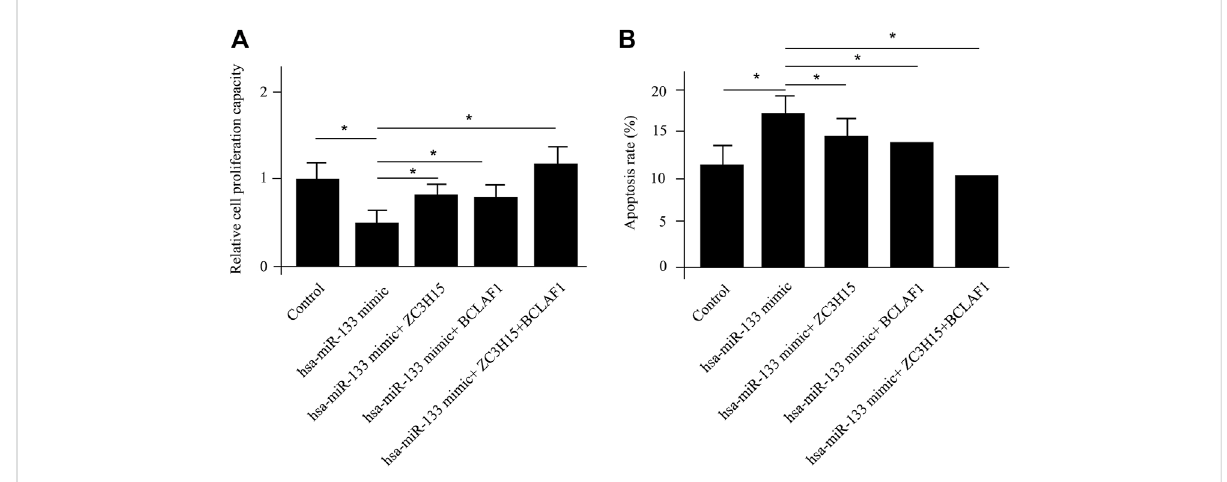
FIGURE 4 Invitro veri fi cationofdifferentiallyexpressed mRNAsandmiRNAs. Thecell proliferation capacity (A) andcellapoptosis analysis (B) forNB4cells with different treatments.